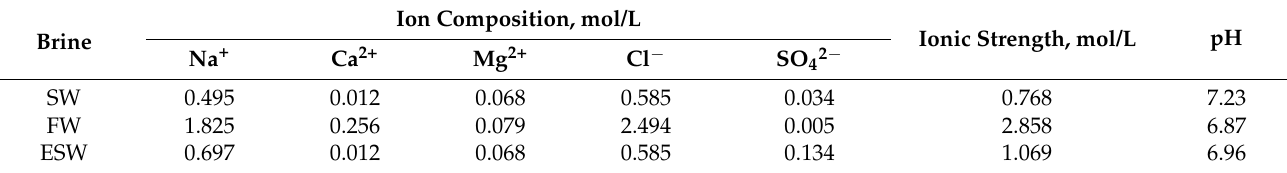
Table 1. Properties of the brine (approximate